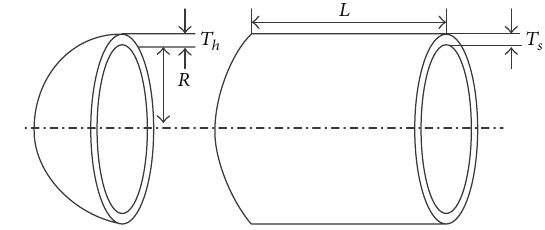
Figure 20: Diagram of pressure vessel